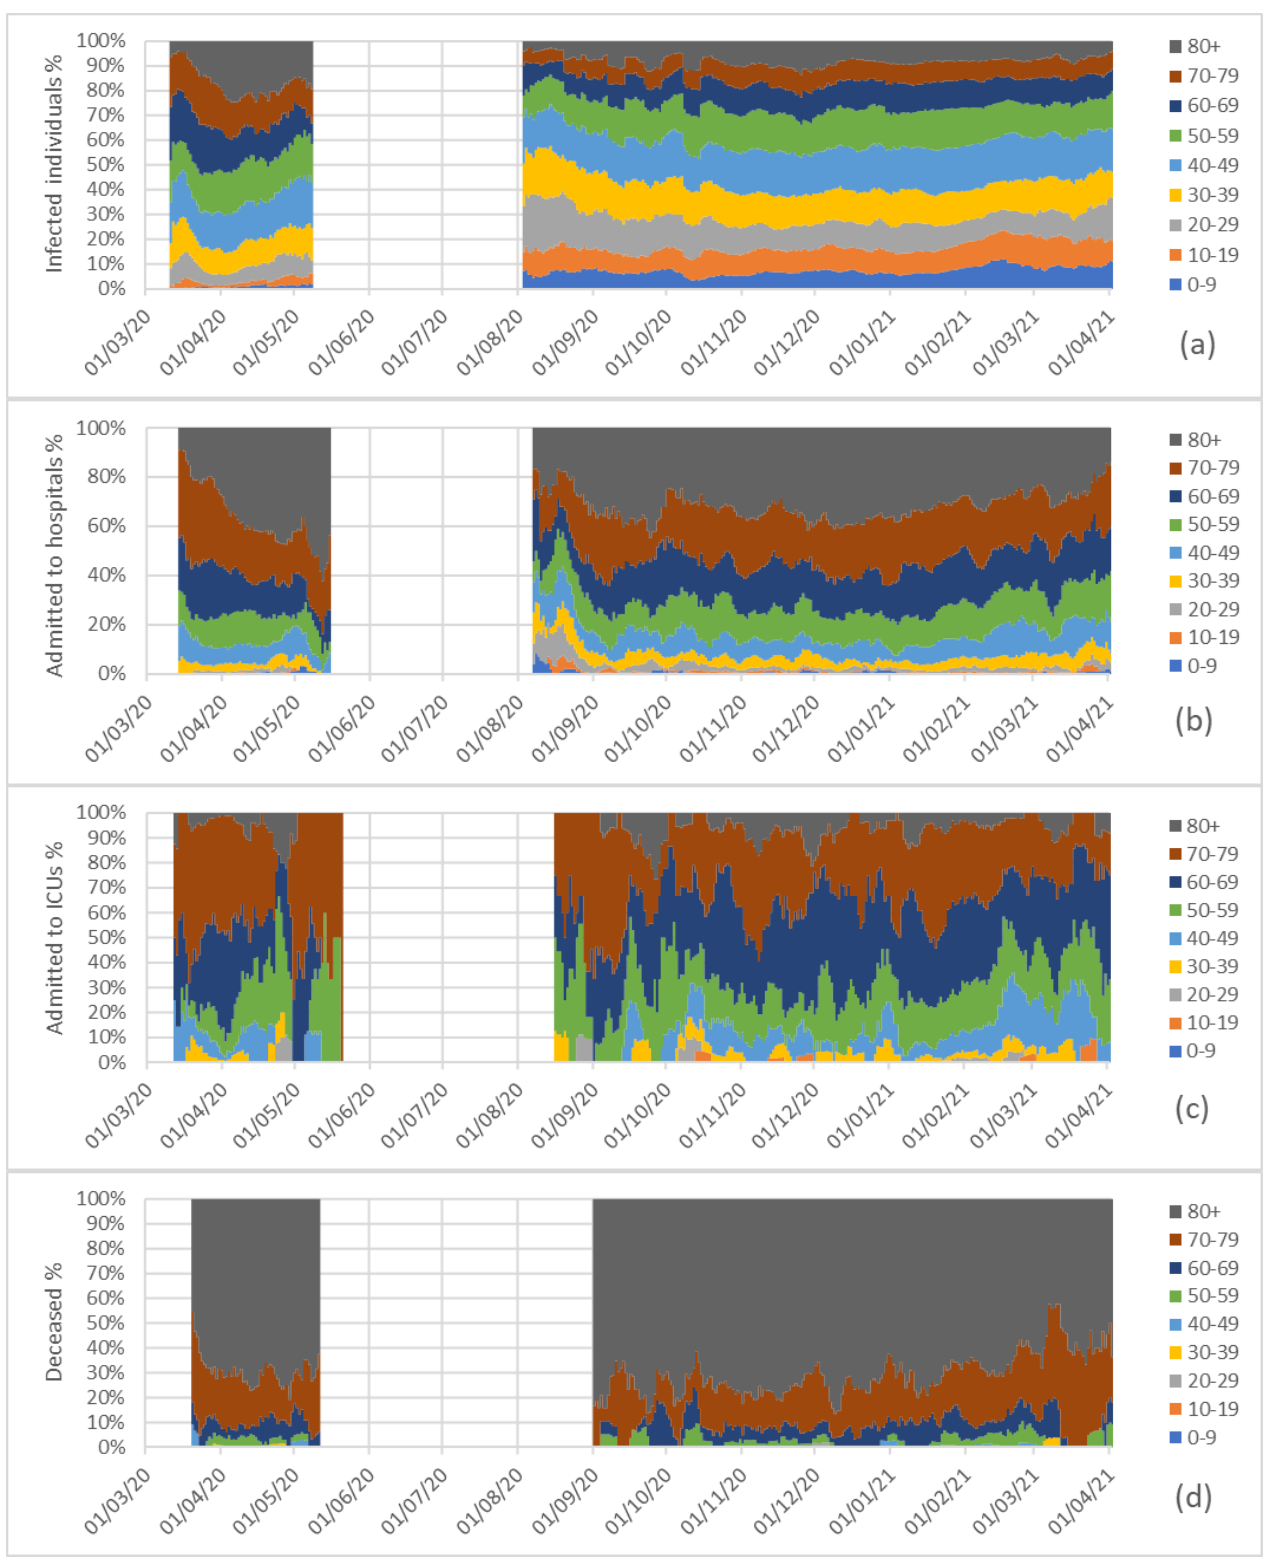
Figure 3. Percentages of newly infected ( a ), admissions to hospitals ( b ), admissions to intensive care units ( c ) and deceased ( d ) in Galicia since the beginning of the pandemic, by considering age groups and means of the seven previous days.